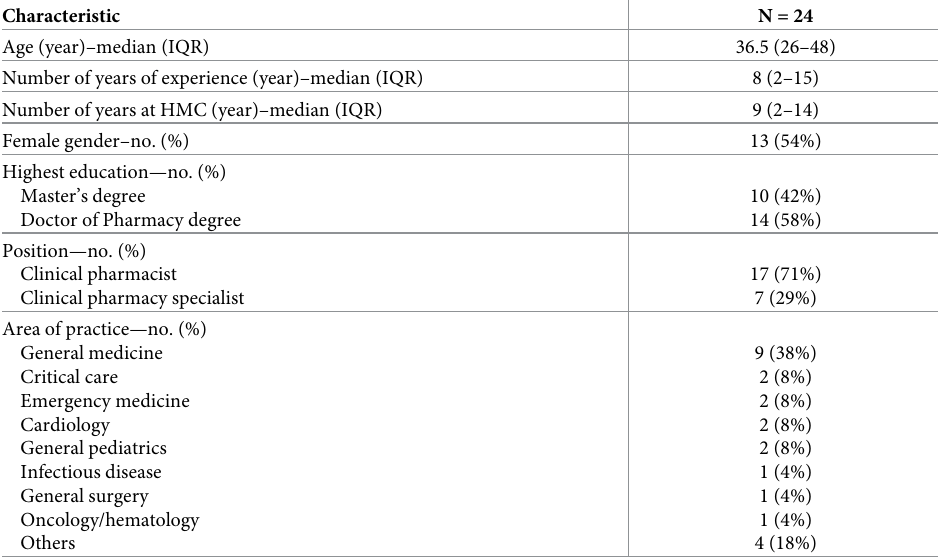
Table 1. Participants’ demographic and practice characteristics.